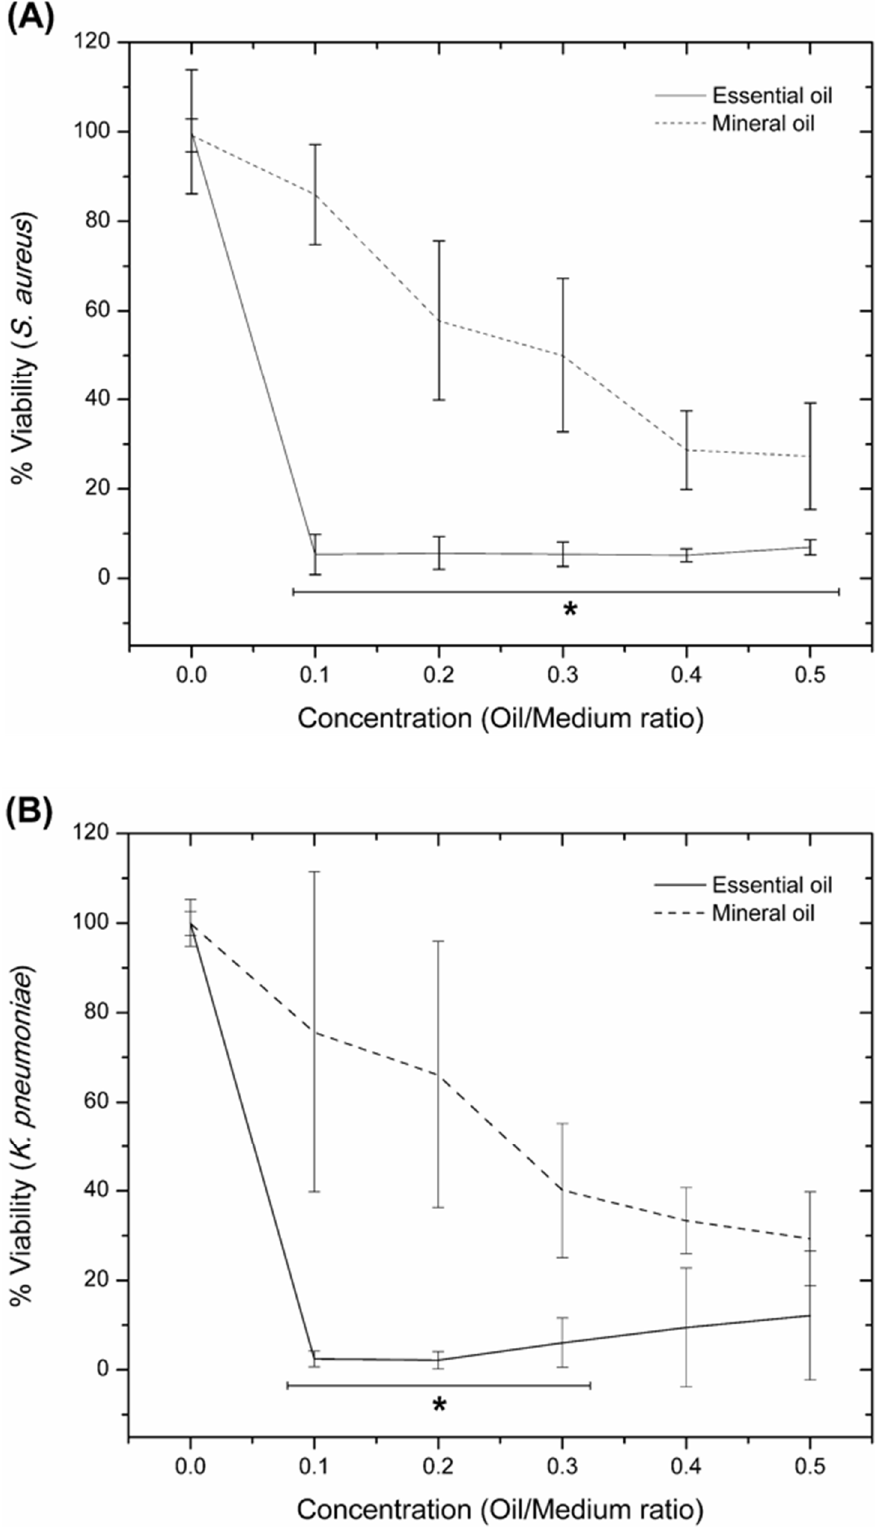
Figure 1. Bacterial growth inhibition in the presence of L. philippiana essential oil and mineral oil. The effect of different volume/volume ratio of essential oil (solid line) and mineral oil (segmented line) was evaluated using ( A ) S. aureus and ( B ) K. pneumoniae . Results were averaged from 3 independent experiments ( n = 3). Statistically significant differences ( p < 0.05) compared essential oil and mineral oil treatments are indicated with an asterisk